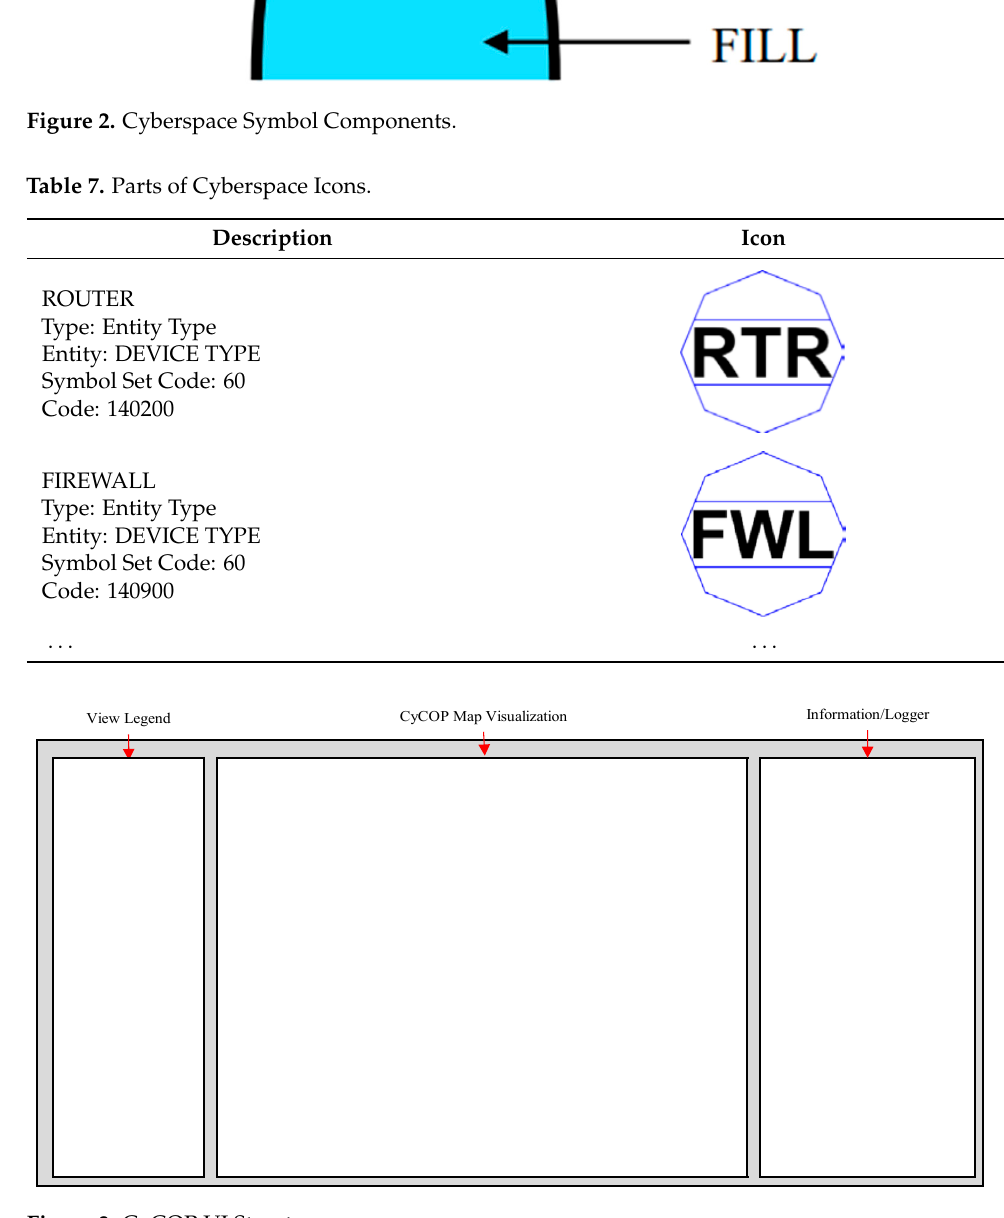
Figure 3. CyCOP UI Structure. Figure 3. CyCOP UI Table 8. Distance based on Wall Screen Size. Table 7. Parts of Cyberspace Icons.